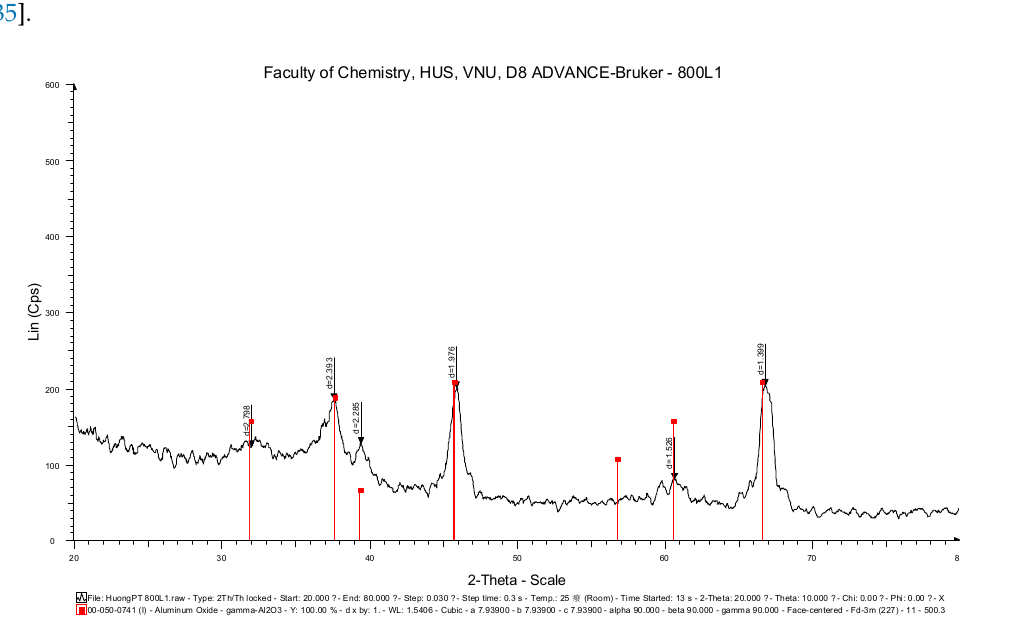
2 O 3 nanoparticles.